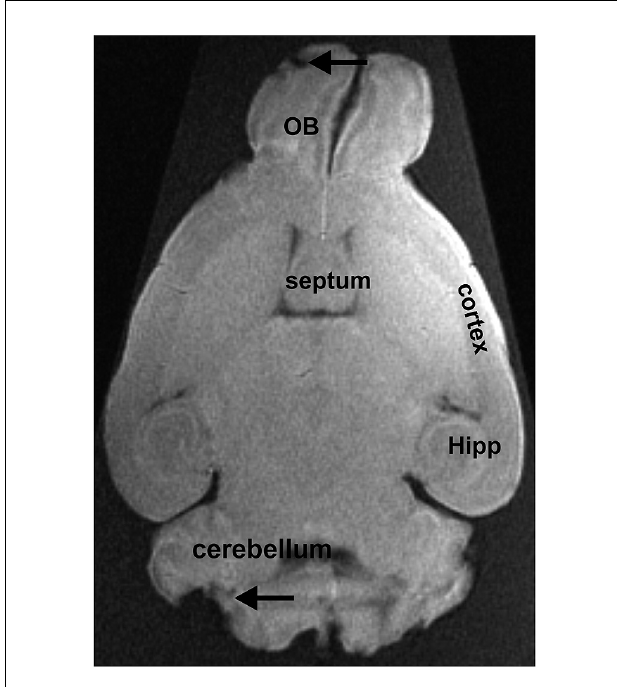
FIGURE 3 | Extracted brain tissue that was fixed for several days. The olfactory bulbs (OB), the cortex, the hippocampus (Hipp), and the cerebellum can easily be distinguished from adjacent brain regions. Due to the removal of the brain from the surrounding tissue, some damage can be noted, as e.g., in the cerebellum or the OB (indicated by arrows).